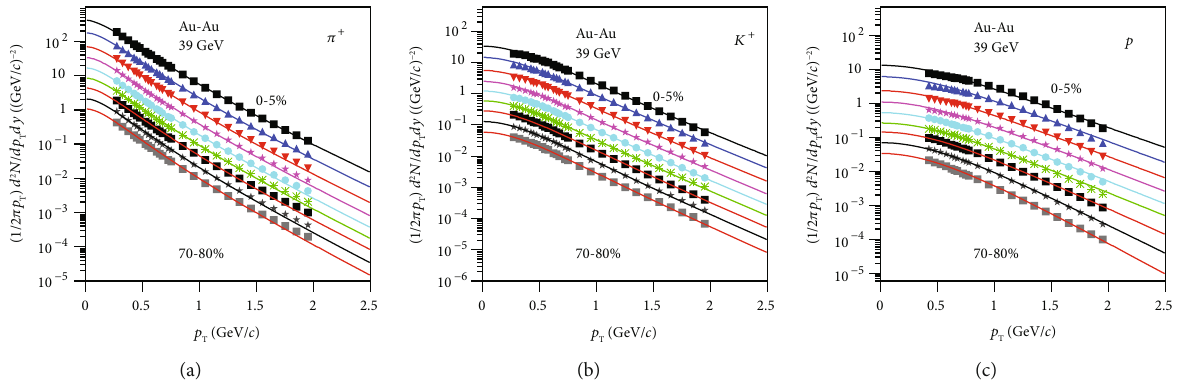
Figure 6: The same as Figure 1, but showing the results at